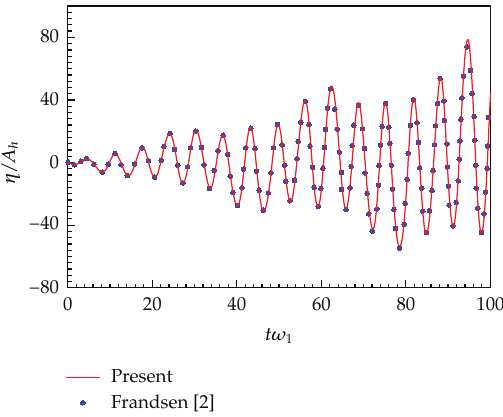
Figure 4: Time history of wave surface at the left tank wall due to coupled horizontal and vertical